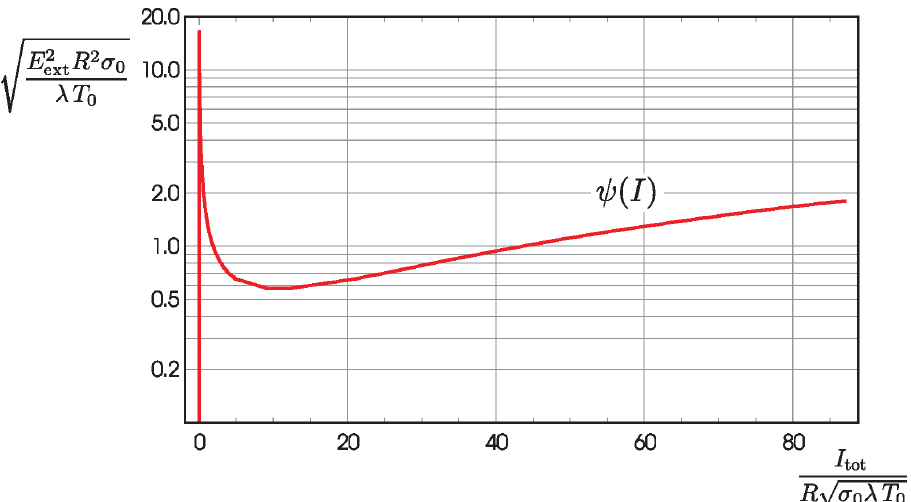
Figure 1. Current-voltage characteristic with the three phases (capacitor, arcing, burning). Both the current and the electric field are normalised: σ 0 = 1 × 10 4 A/ ( Vm ) is the conductivity scaling factor; T 0 = 3 × 10 3 degK is the temperature scaling factor; λ = 8 × 10 2 W/ ( mK ) is the heat conductivity scaling factor; R is the radius of the cylinder containing the plasma column. (From [57], reproduced with